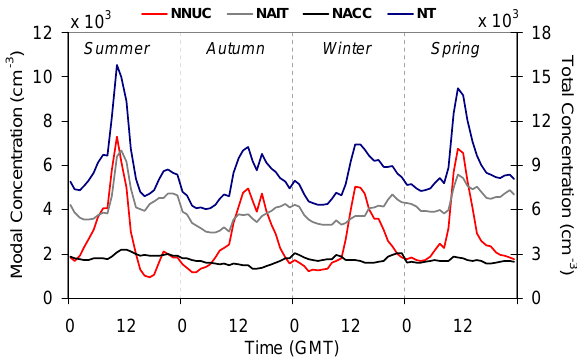
Fig. 5. Daily mean cycles of the total and nucleation, Aitken and ac- mer), October–December (autumn), January–March (winter) and April–June